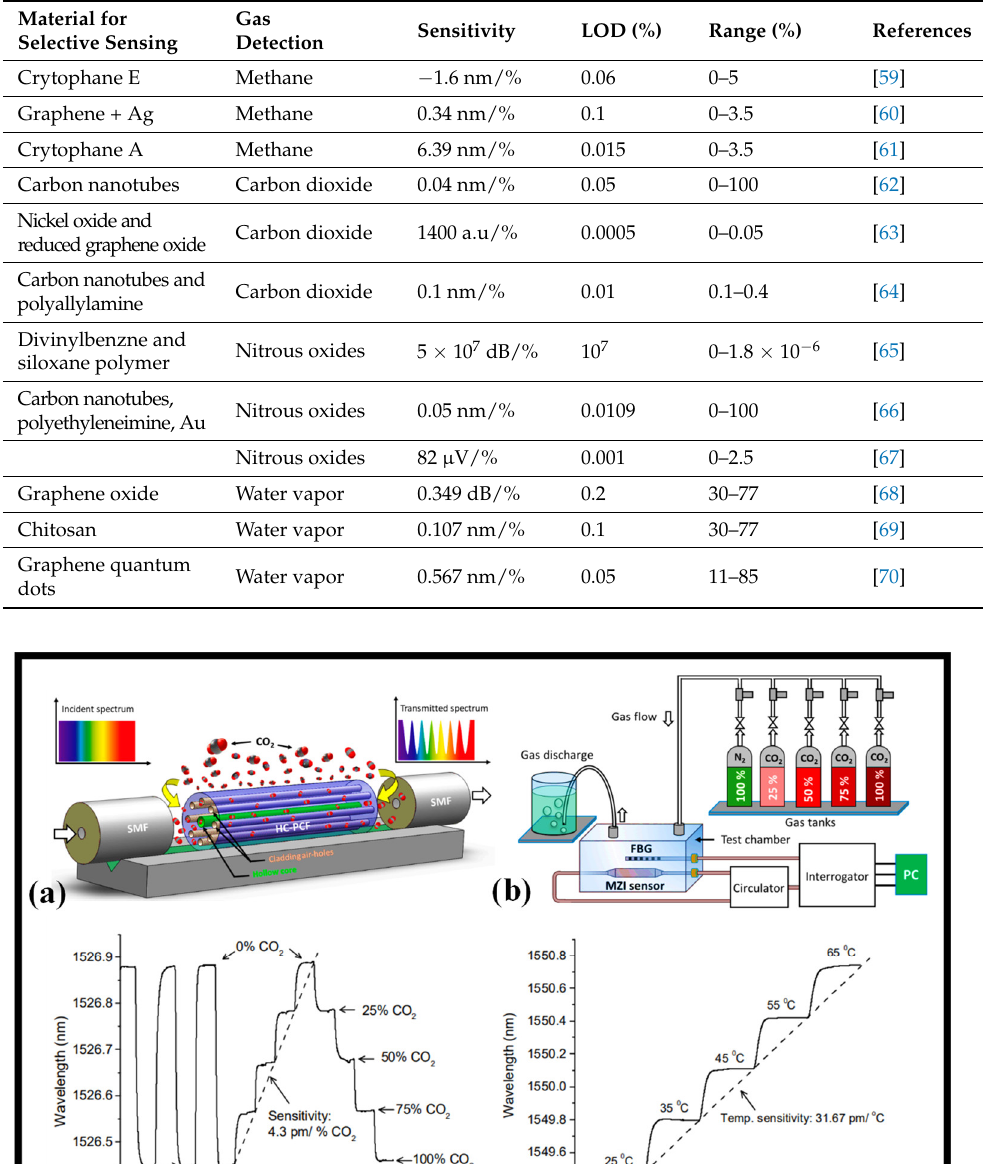
Table 1. Optical fiber-based gas sensors.